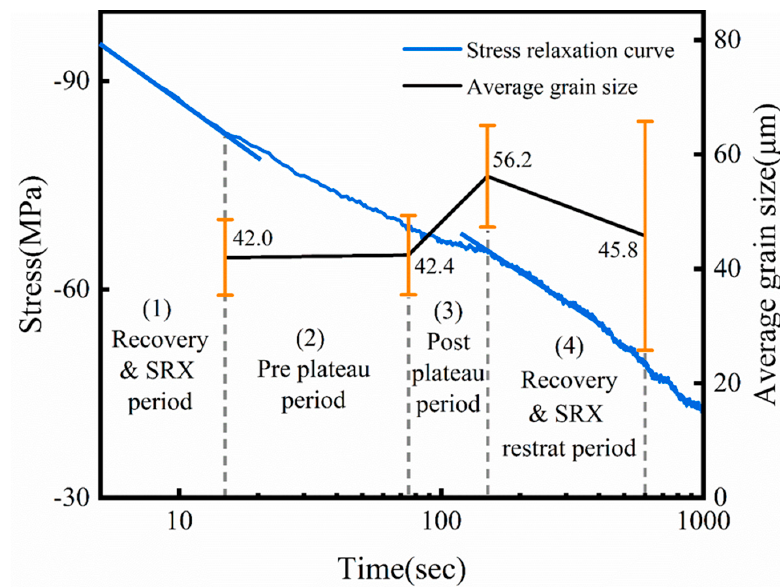
Figure 11. Evolution of the correlation between SIP and SRX during stress relaxation at 900 °C.